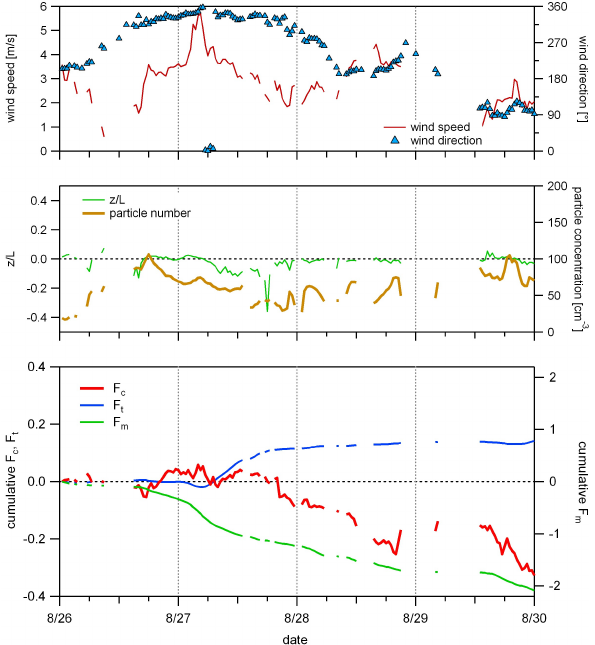
Fig. 5. Top panel shows wind speed (red line) and relative wind direction (triangles) from 26 August through 29 August 2008; mid- dle panel shows stability parameter z / L (green line) and particle number concentration (orange line); bottom panel shows cumulative fluxes of momentum ( F m , green), buoyancy ( F t , blue), and particle number ( F c , red).